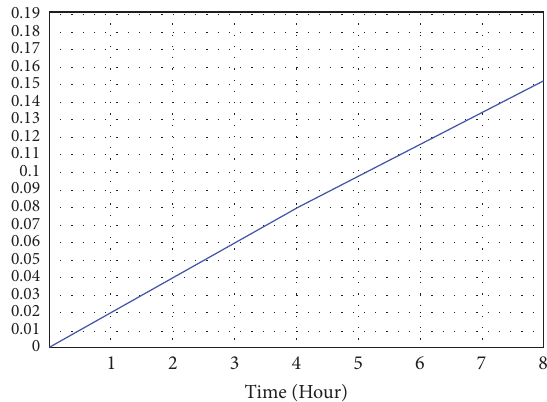
Figure 6: Equipment failure rate based on 8h of work.